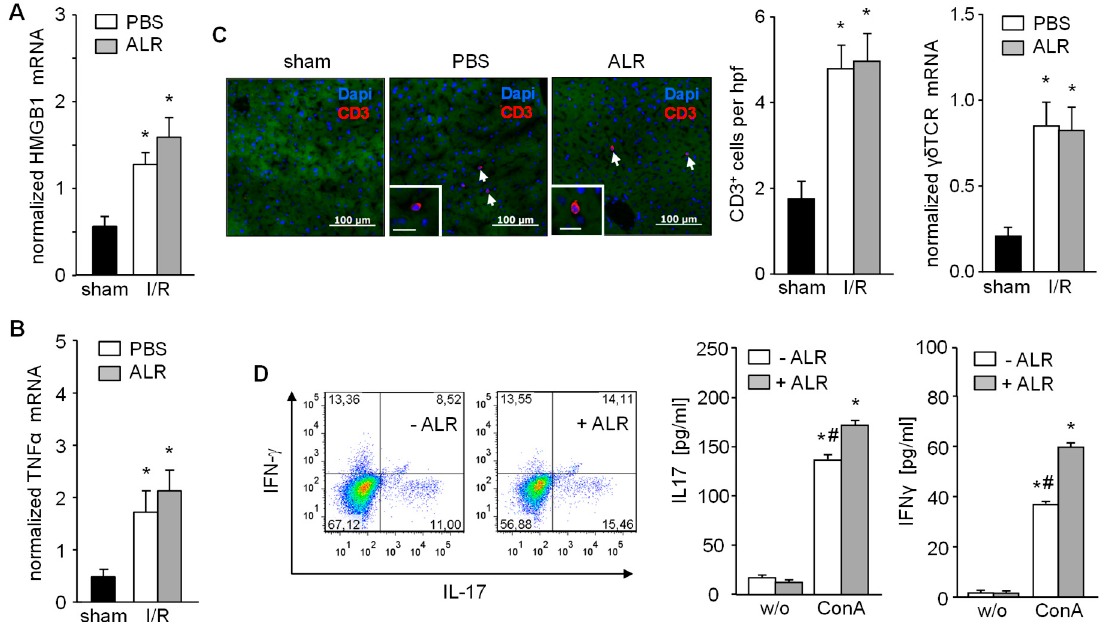
Figure 2. Expression of HMGB1 and TNF α , recruitment of CD3 + and activation of γδ T cells after IR are not diminished upon ALR treatment. Liver tissues from IR mice were analyzed for ( A ) HMGB1 and ( B ) TNF α mRNA expression ( n = 5). ( C ) Liver tissues were immuno-stained for CD3 + cells and number of infiltrated CD3 + cells were analyzed in each group ( n = 6). Expression of γδ T cell receptor ( γδ TCR) mRNA in liver tissue samples was analyzed by qRT-PCR ( n = 5). Gene expression was normalized to 18S. * p < 0.05 di ff ers from sham. ( D ) γδ T cells were isolated from mouse livers and treated in culture with or without rALR (100 ng / mL, 48 h) followed FACS analysis for IL-17 and IFN- γ expression ( n = 3). Furthermore, release of IL-17 and IFN- γ into the supernatant of cultured γδ T cells after stimulation with concanavalin A (ConA, 2 ng / mL, 48 h) in the presence or absence of rALR (100 ng / mL, 48 h) were determined by ELISA ( n = 3). * p < 0.05 or # p < 0.05 di ff ers from unstimulated or corresponding stimulated γδ T cells, respectively.